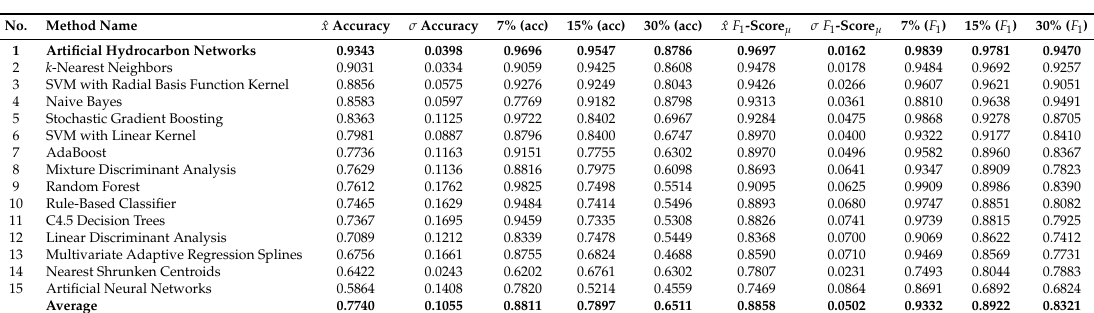
Table 20. Overall performance of supervised classifiers during the experiments with 7%, 15% and 30% noisy